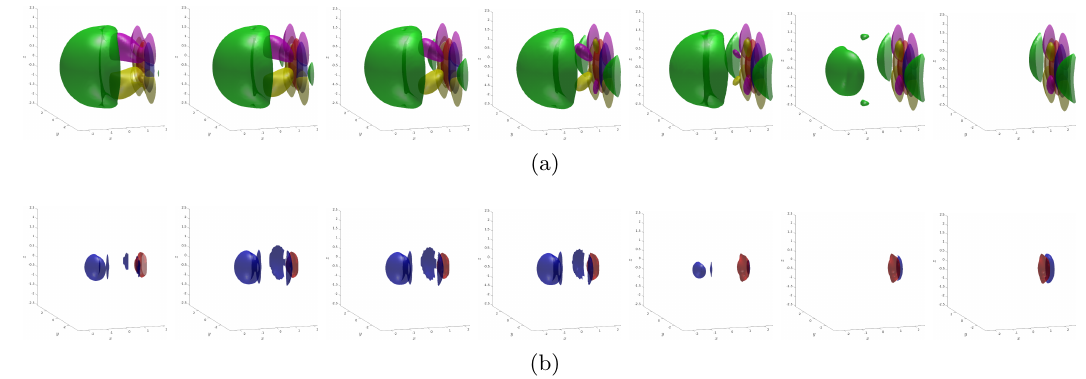
4 of their respective 4 , 2